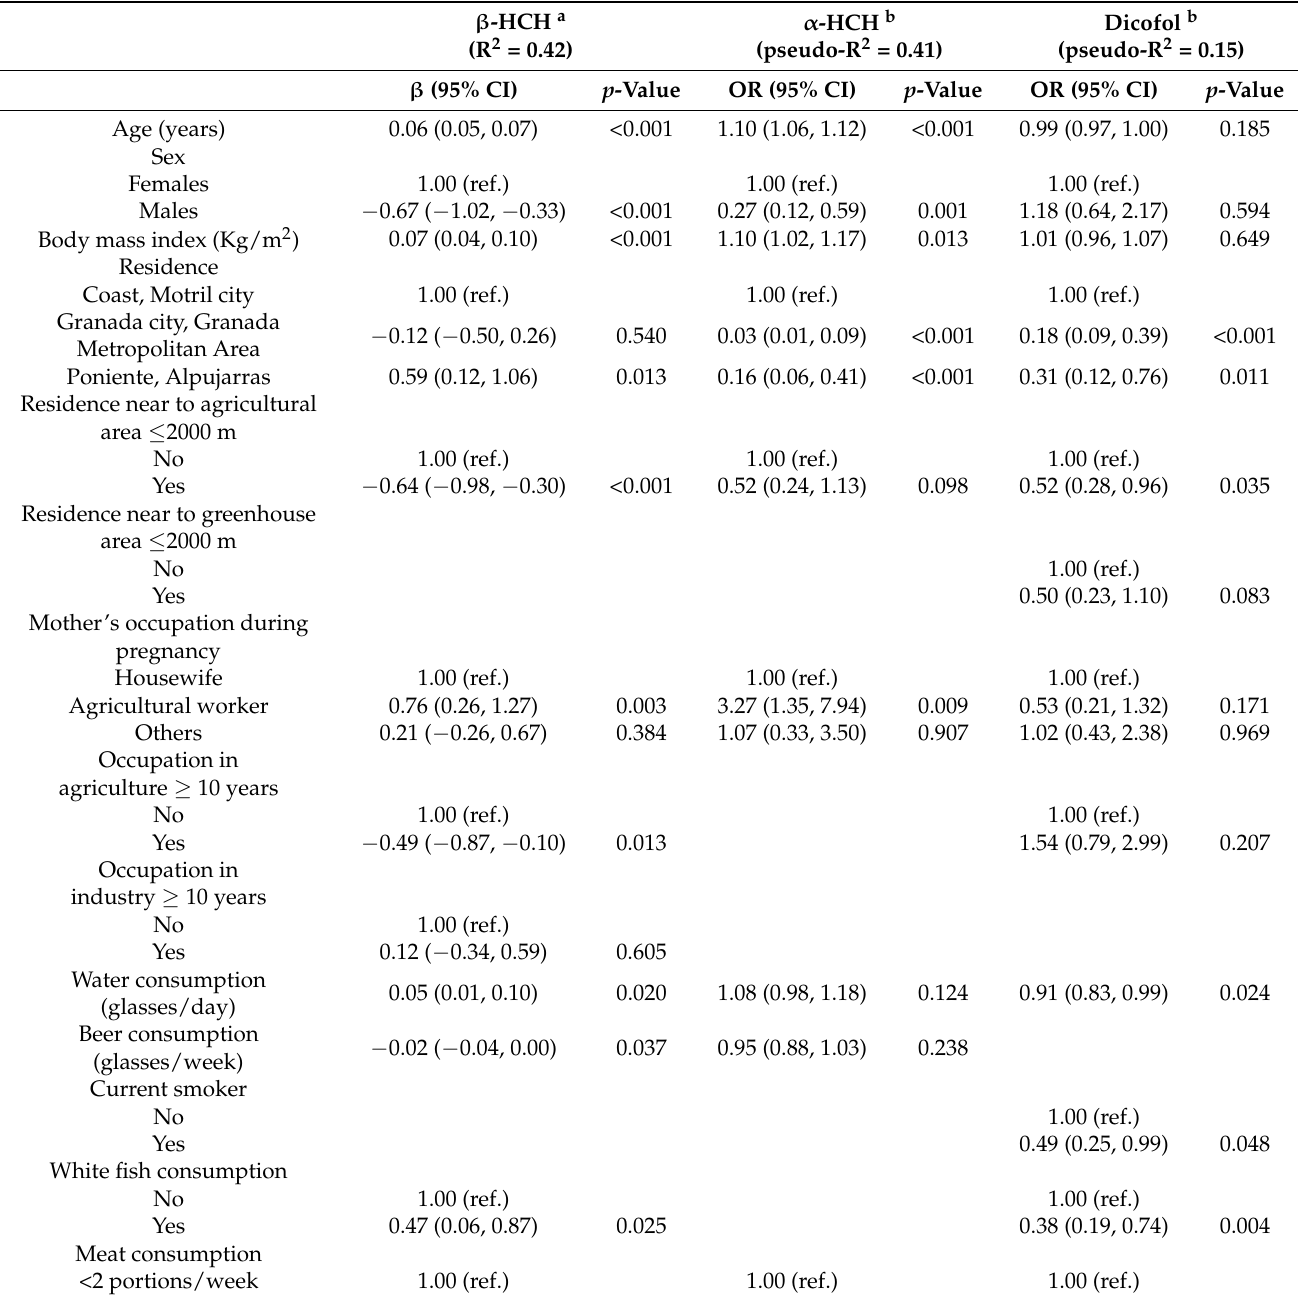
Table 2. Predictors of adipose tissue β -HCH, α -HCH, and dicofol concentrations in GraMo cohort ( n =